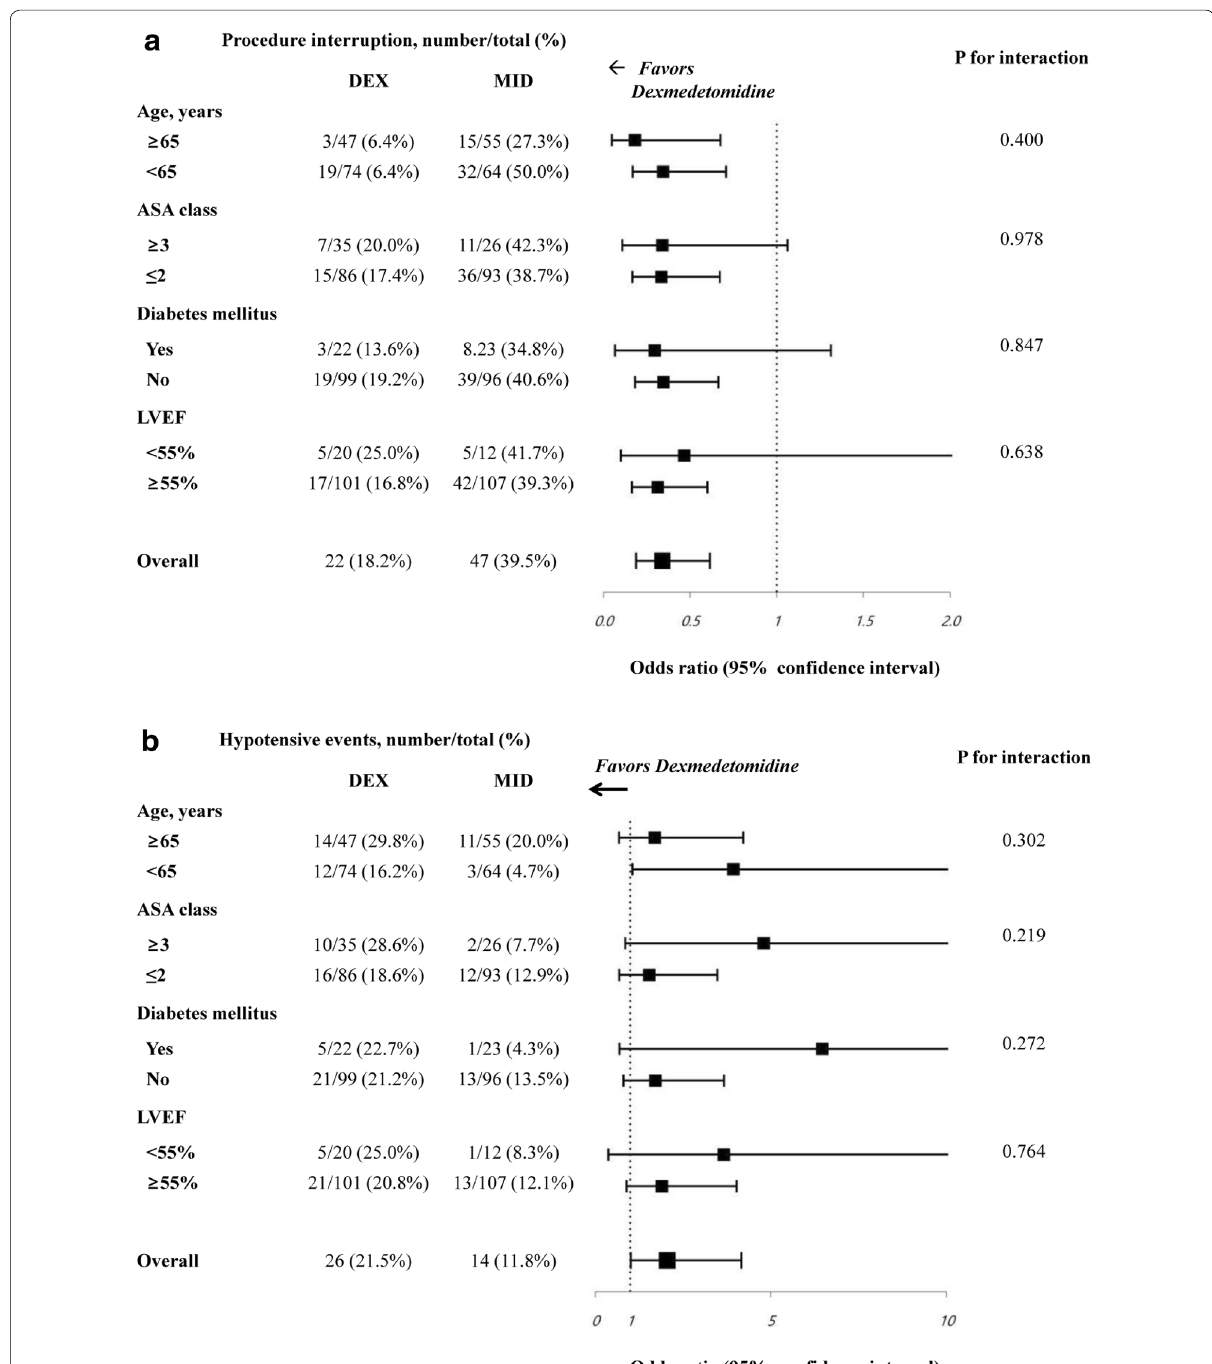
Fig. 2 Subgroup analyses in different predefined sub‑populations for the primary end point ( a ) and the incidence of hypotension (systolic blood pressure < 80 mmHg) ( b ). DEX: dexmedetomidine with remifentanil, MID: midazolam with fentanyl, ASA: American Society of Anesthesia, LVEF: